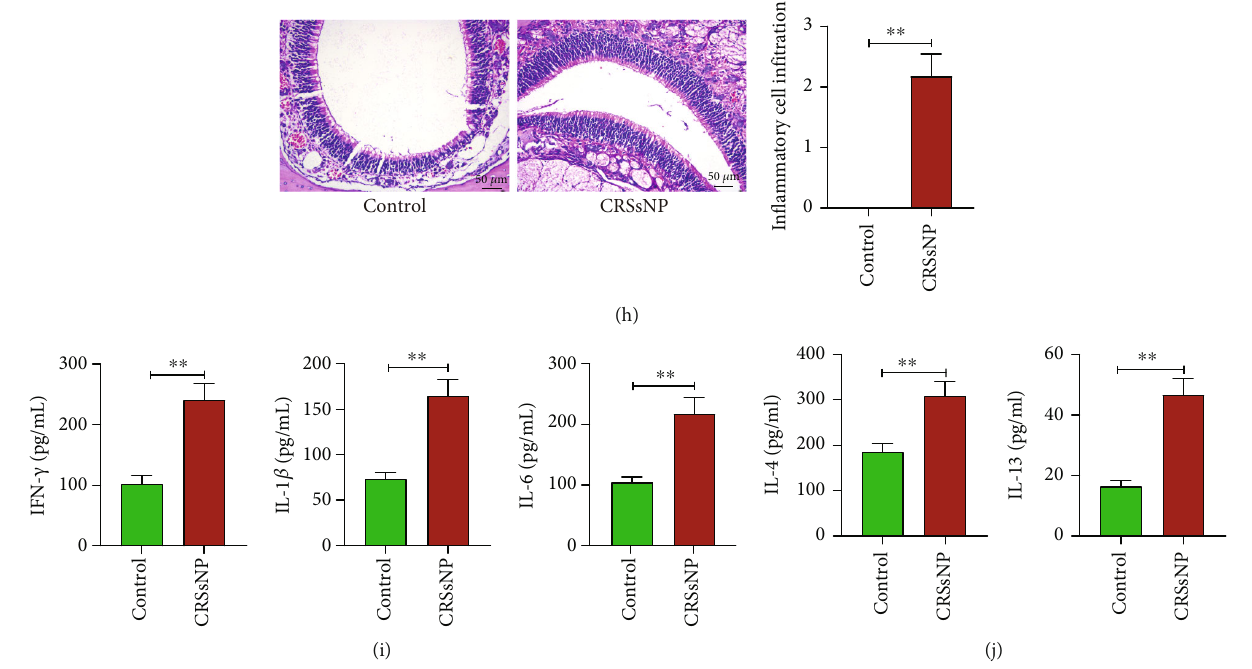
Figure 1: XBP1 is highly expressed in CRSsNP patients and CRSsNP mice. (a) Highly expressed XBP1 in CRSsNP screened using the GSE69093 dataset. (b) Analysis of di ff erentially expressed genes of in the GSE194282 dataset. (c) RT-qPCR analysis of XBP1 expression in collected nasal mucosal tissue samples from CRSsNP patients and controls. (d) The levels of in fl ammatory factors IFN- γ , IL-1 β , and IL-6 in nasal mucosal tissues of patients with CRSsNP and controls measured using ELISA. (e) The levels of in fl ammatory factors IL-4 and IL-13 in nasal mucosal tissues of patients with CRSsNP and controls measured using ELISA. (f) RT-qPCR analysis of XBP1 expression in nasal mucosal tissue samples from CRSsNP mice and controls. (g) Mucin expression in nasal mucosal epithelial cells of CRSsNP mice and controls examined using PAS staining. (h) Pathological changes of nasal mucosa in mice with CRSsNP and controls observed by HE staining. (i) The levels of in fl ammatory factors IFN- γ , IL-1 β , and IL-6 in nasal mucosal tissues of mice with CRSsNP and controls measured using ELISA. (j) The levels of in fl ammatory factors IL-4 and IL-13 in nasal mucosal tissues of mice with CRSsNP and controls measured using ELISA. ∗∗ p < 0 : 01 versus the control participants or mice. The data are measurement data, presented as mean ± SD . Data between two groups were compared using an unpaired t test. The experiment was independently repeated three times. n = 6